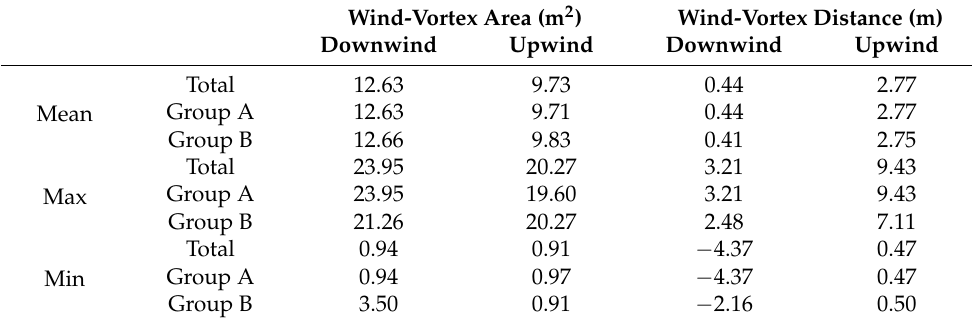
Table 3. Data differences .